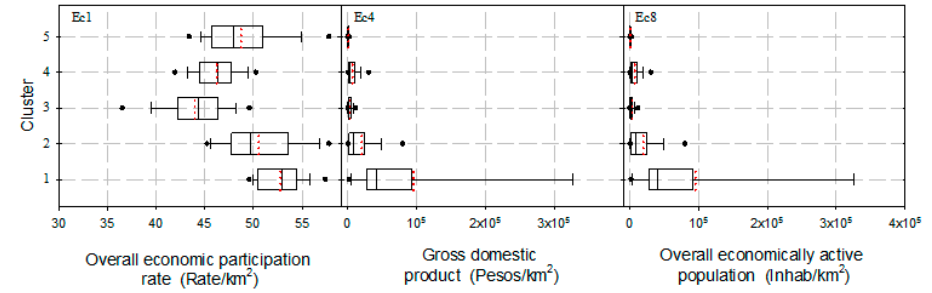
Figure 8. Regional economic characteristics with real values. Average value is the dotted red line.